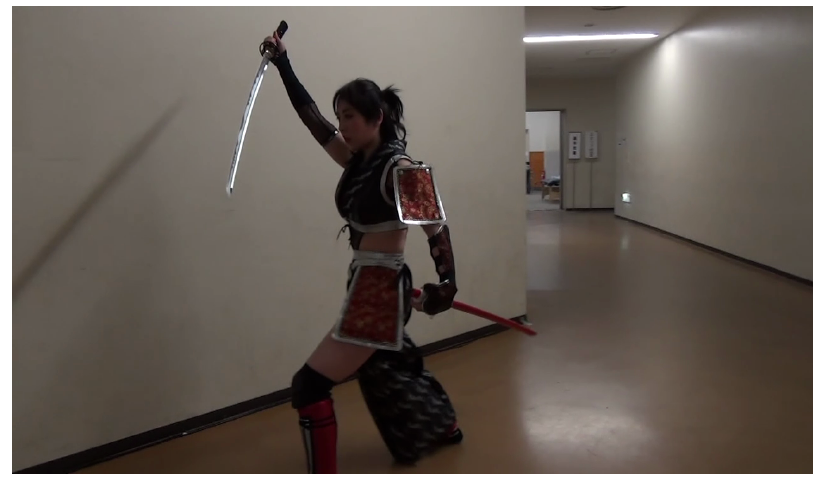
Fig. 2. Yasukawa with a katana . Gamushara (Takahara,